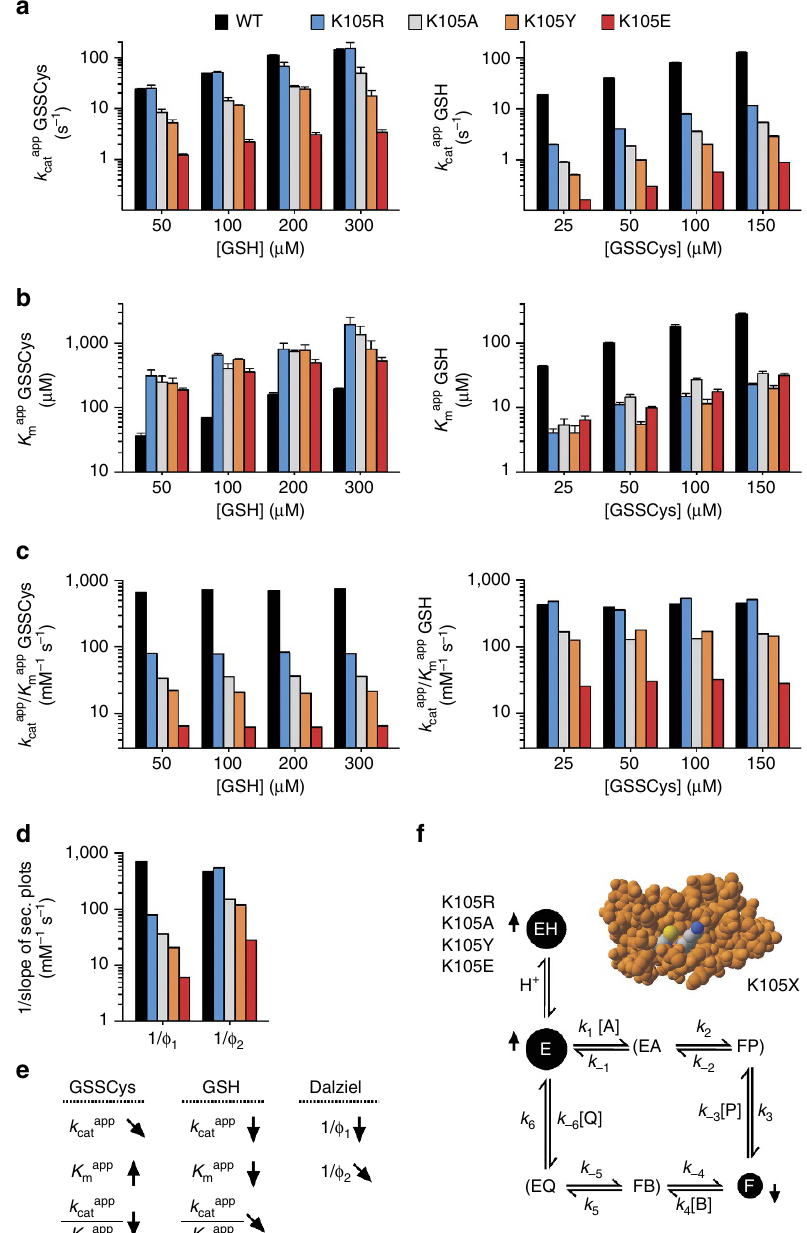
Figure 2 | Lys105 is crucial for the oxidative and reductive half-reaction of the GSSCys assay. ( a , b ) Selected k cat app and K m app values of ScGrx7 wild-type enzyme and K105X mutants for GSSCys and GSH. ( c ) Calculated catalytic efficiencies from a and b . ( d ) Reciprocal Dalziel coefficients, which probably reflect the rate constants of the oxidative and reductive half-reaction with GSSCys and GSH, respectively. ( e ) Summary of the altered kinetic parameters for K105A/Y/E. ( f ) Data interpretation based on a general ping-pong mechanism. Altered concentrations of the active free enzyme ‘E’ (thiolate form), glutathionylated enzyme ‘F’ and inactive protonated enzyme ‘EH’ upon mutation of Lys105 are highlighted. GSSCys and GSH correspond to substrates A and B, respectively. Cysteine and GSSG correspond to products P and Q, respectively. Original plots and kinetic parameters for a – c are shown in Supplementary Fig. 2 and Supplementary Table 2 and are the mean ± s.d. from at least three independent replicates. Statistical analyses and P -values for the k cat app and K m app values from a and b are listed in Supplementary Table 11. Reciprocal Dalziel coefficients for d were obtained from Supplementary Fig. 3 and are listed together with the true k cat values in Supplementary Table